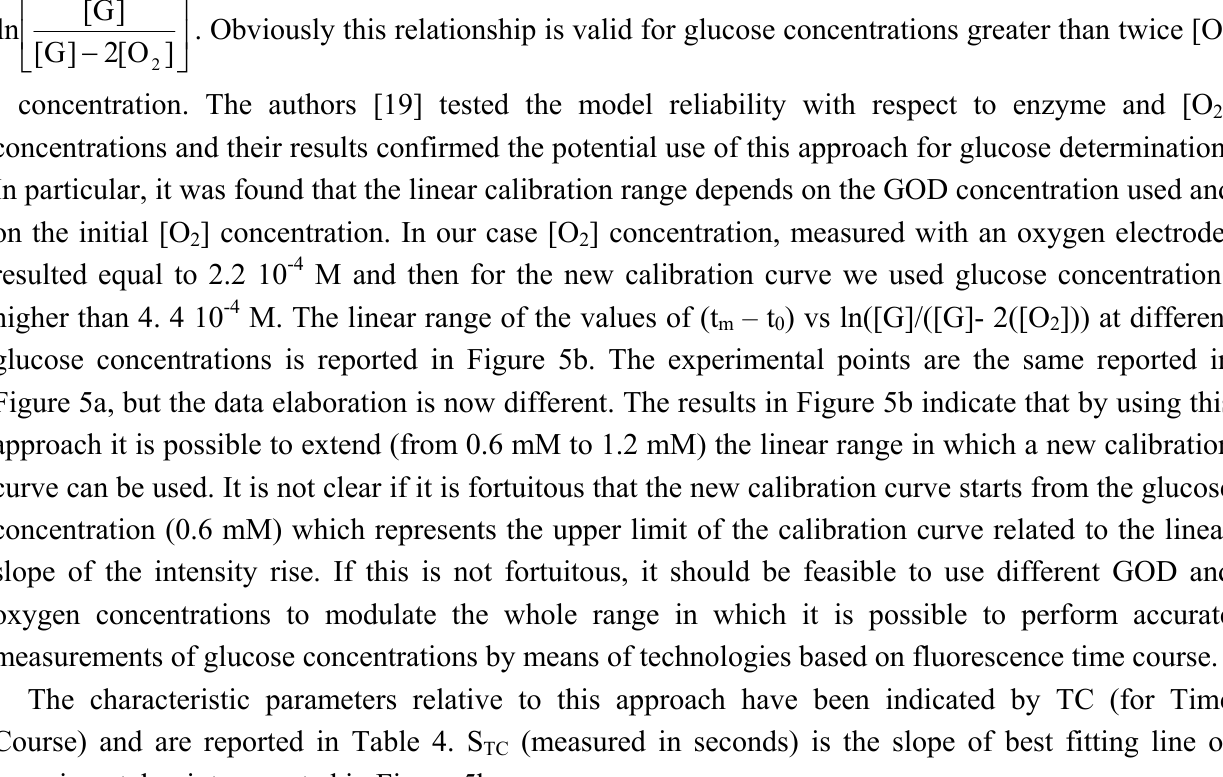
– t ) values as a m 0 ])) at different glucose 2